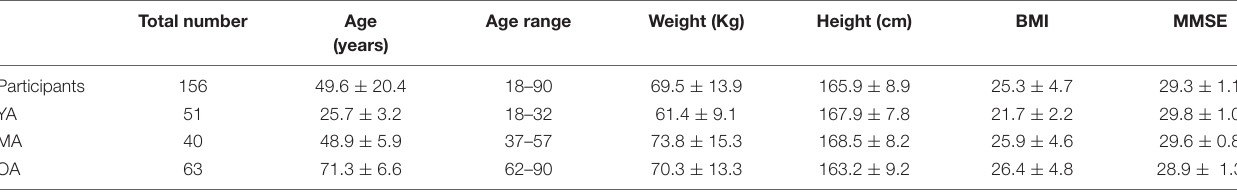
TABLE 1 | Demographic and anthropometric features of participants at the handwriting task. Total